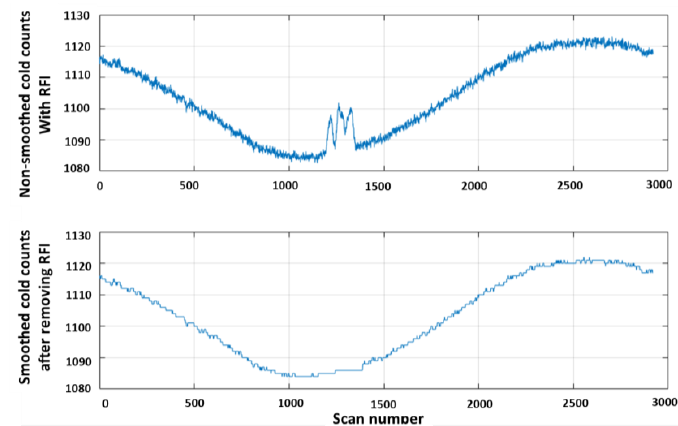
Figure 3. Cold counts with ( bottom panel ) and without ( upper panel ) Radio Frequency Interference (RFI) correction for channel 19.35 H and orbit # 87738.